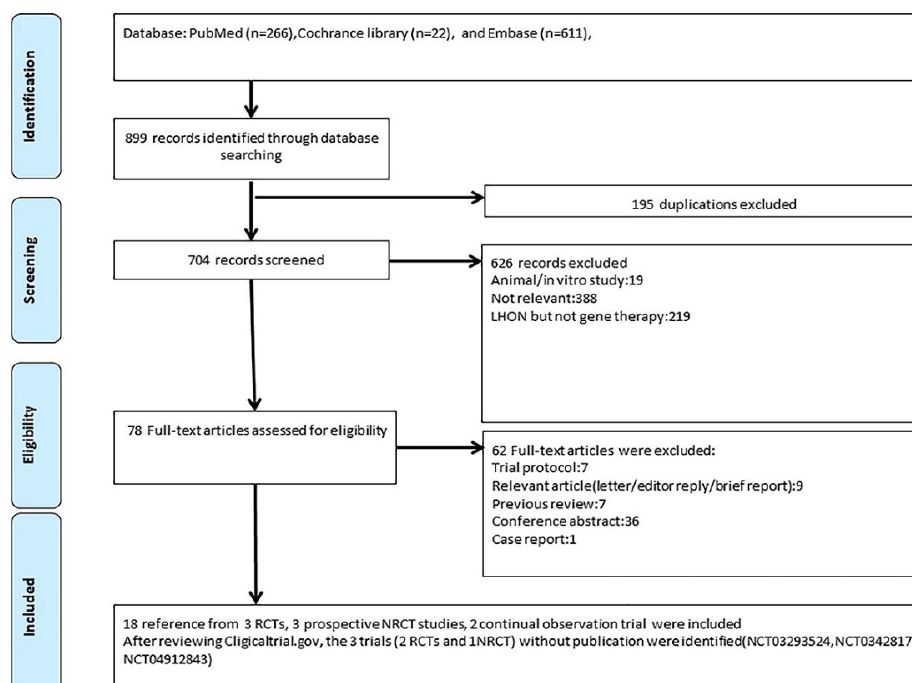
Figure 3. Flowchart of study selection.